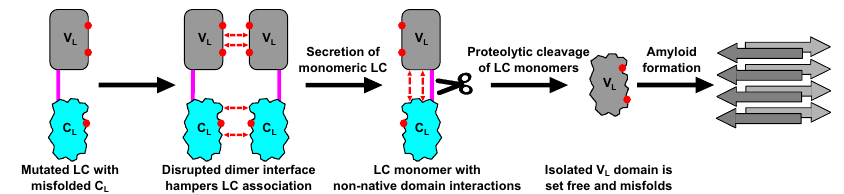
Fig. 7 Schematic representation of the mechanistic steps in the disease pathway of FOR005. The V L domain is shown in gray, the C L in cyan, and the linker connecting the two domains is drawn in magenta. The point mutations are indicated as red dots on the LC domains, the dashed red arrows represent nonnative interactions or disrupted native interactions,